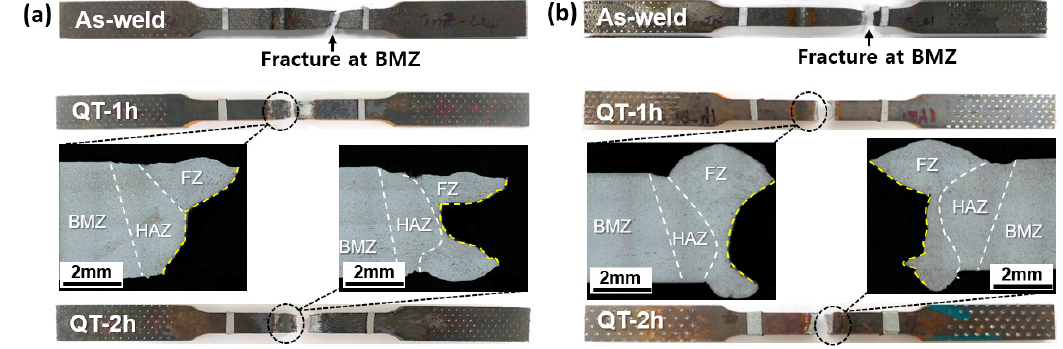
Figure 8. Fractured tensile specimens for the laser-arc hybrid weld joints: ( a ) Type-I and ( b ) Type-II.